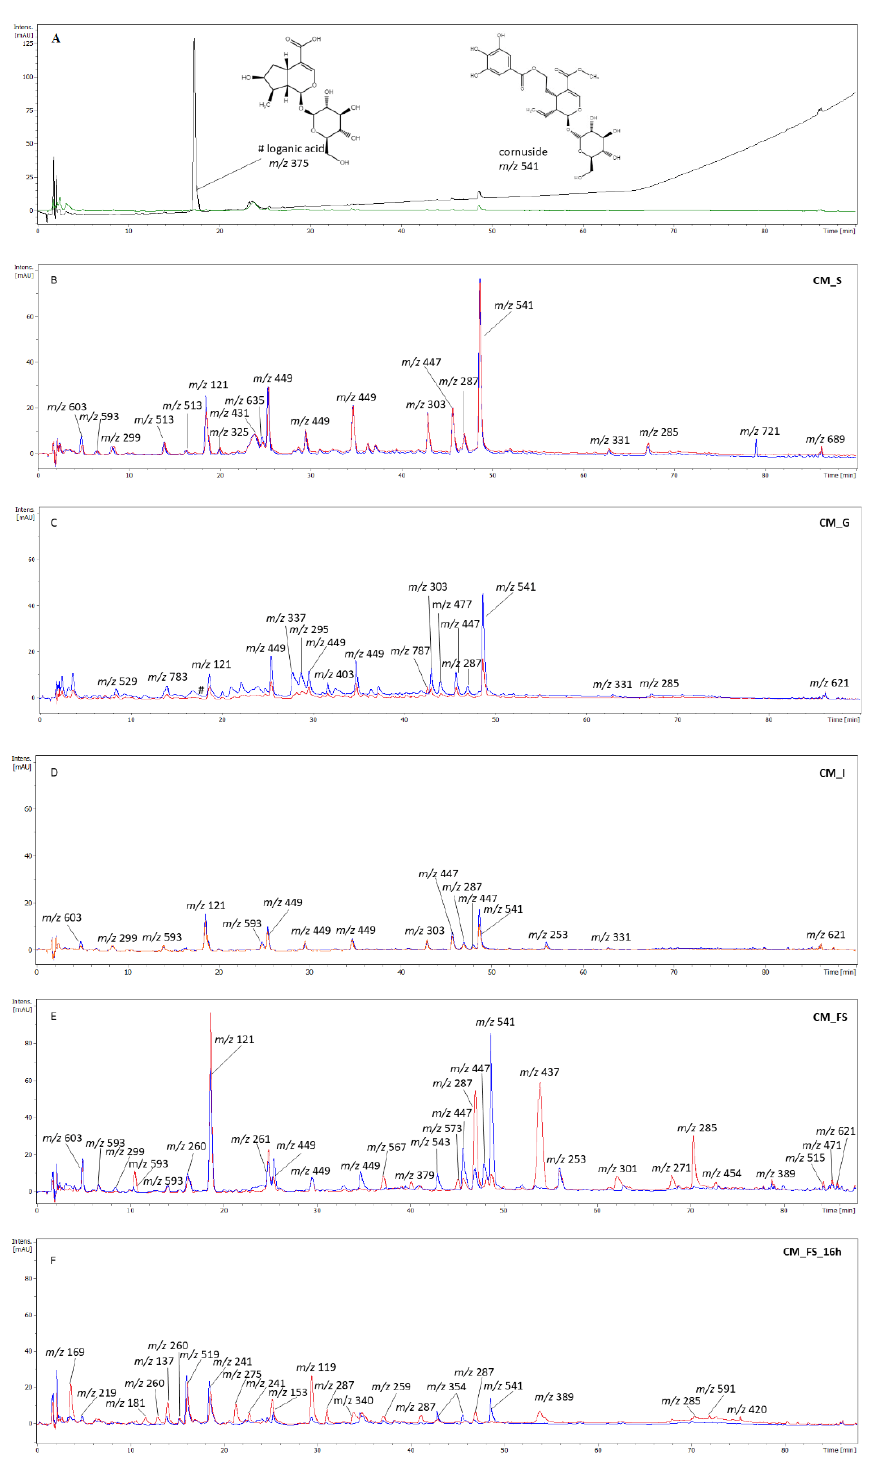
Figure 3. UV (λ = 280 nm) chromatograms of fractions after gastrointestinal digestion of